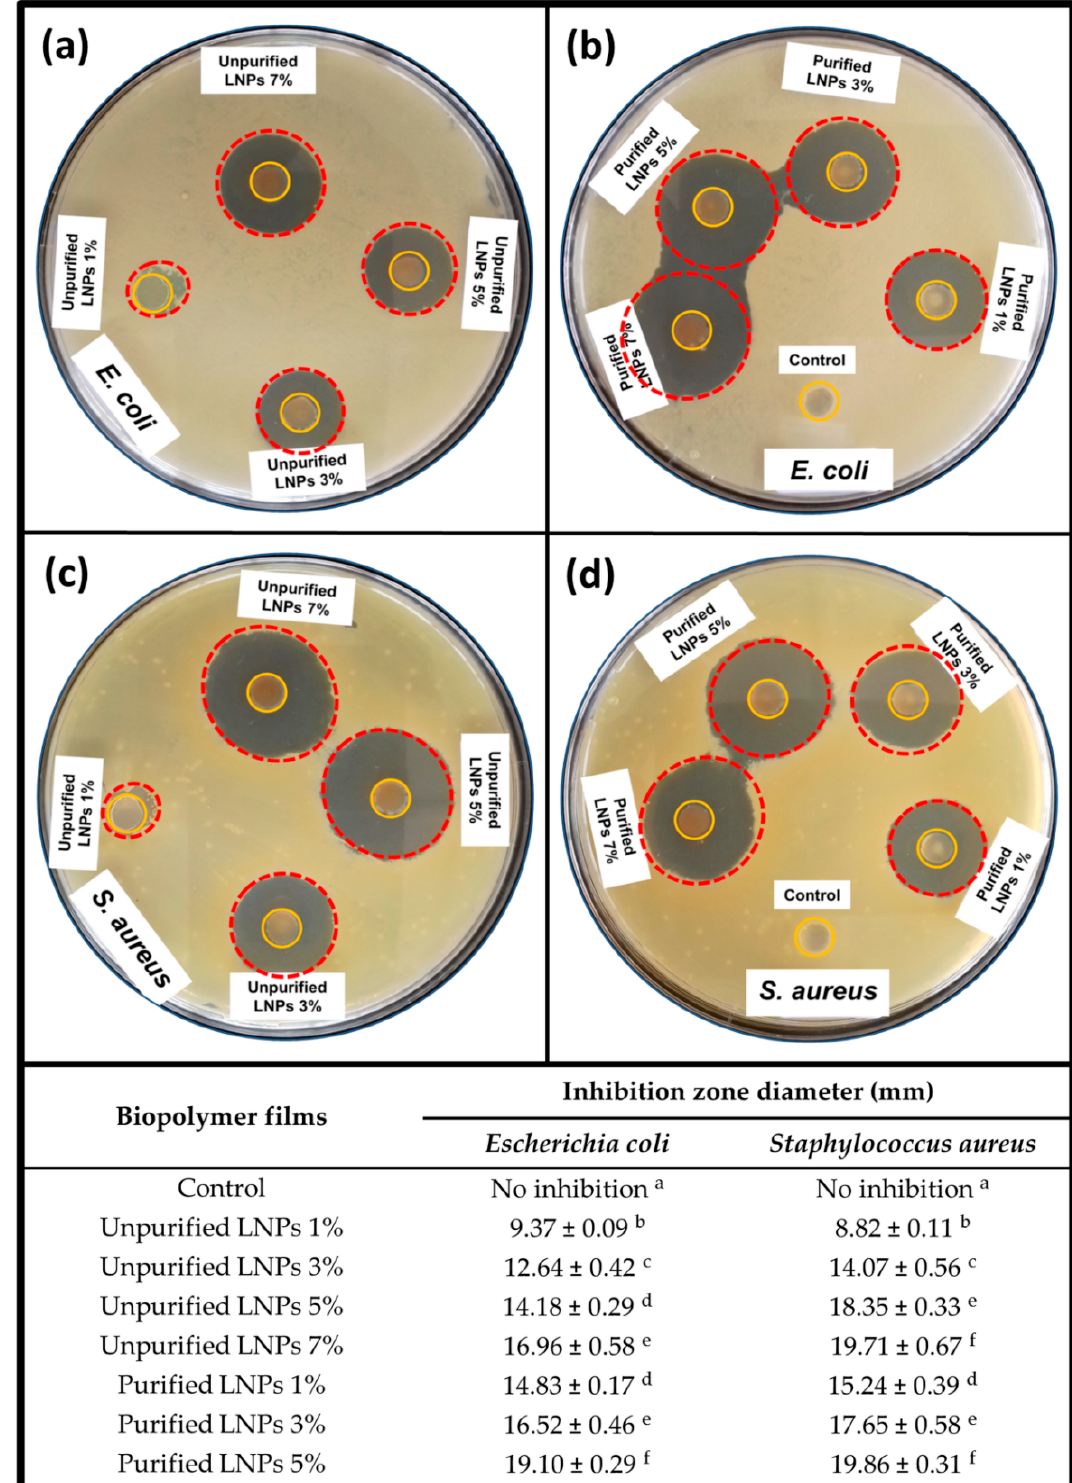
Figure 7. Photographic images and diameter statistics of inhibition zone measurement results of control film and unpurified/purified LNP films at different loadings against ( a , b ) E. coli and ( c , d ) S. aureus . Means of inhibition zone diameter followed by different superscript letters indicate significant differences ( p < 0.05).